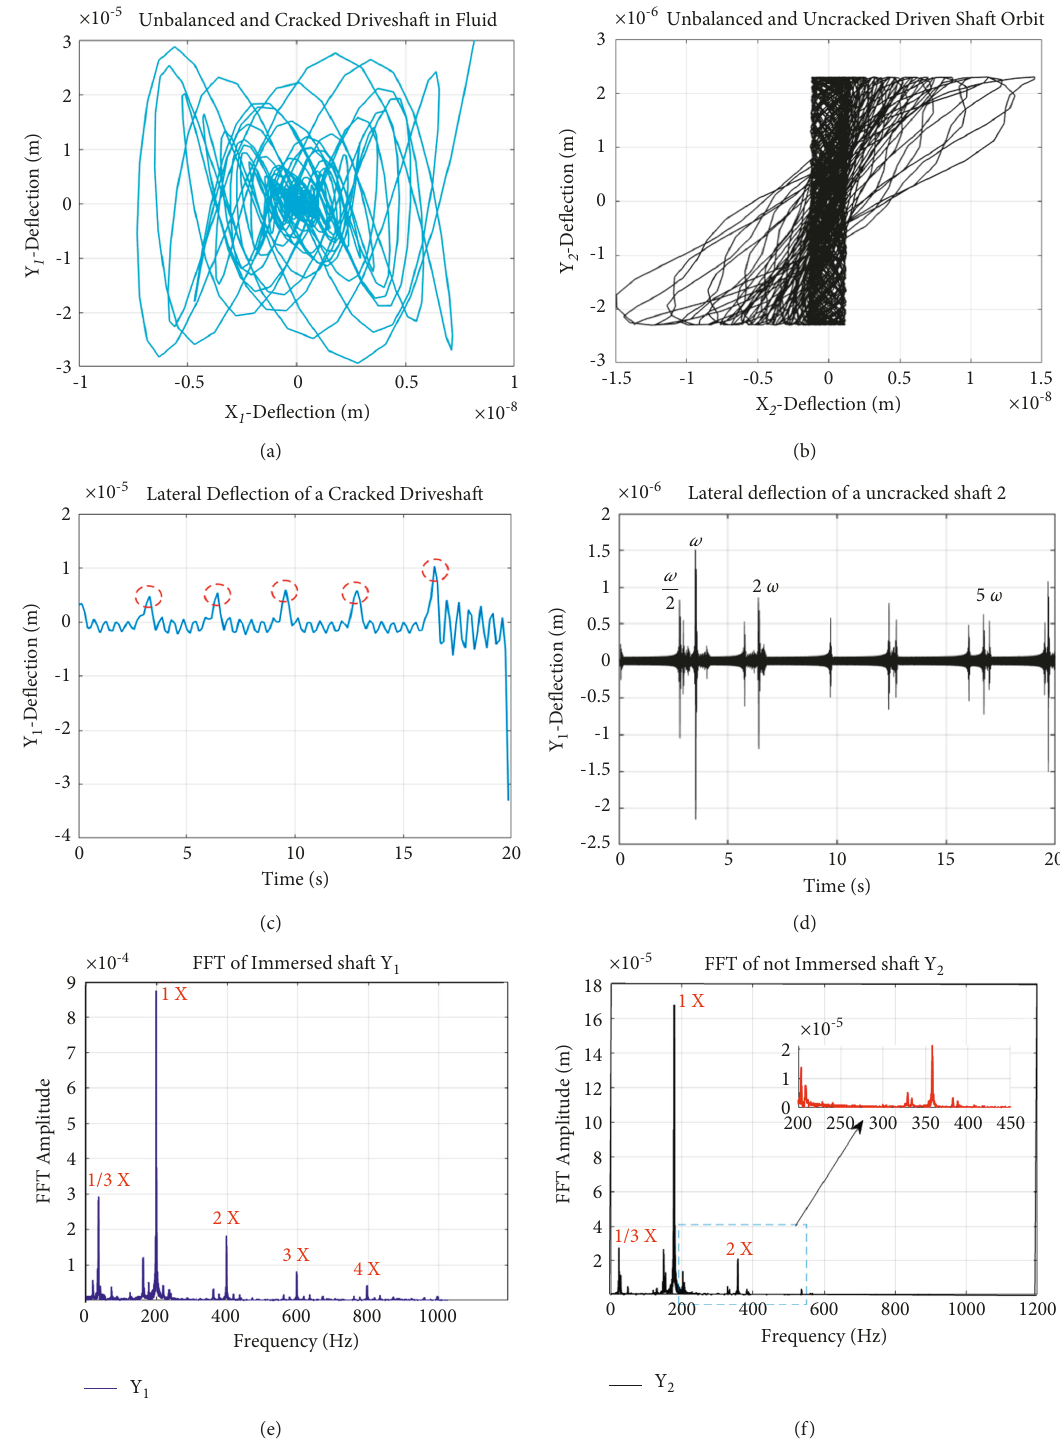
Figure 7: Response of an unbalanced joint Cardan shaft with a crack driveshaft inside a viscous fluid. (b) The orbit of the secondary shaft center. (c) Lateral deflection of the cracked driveshaft in fluid. (d) Lateral response of the uncracked driven shaft. (e) Frequency response of the cracked shaft 1. (f) Frequency result of the uncracked shaft